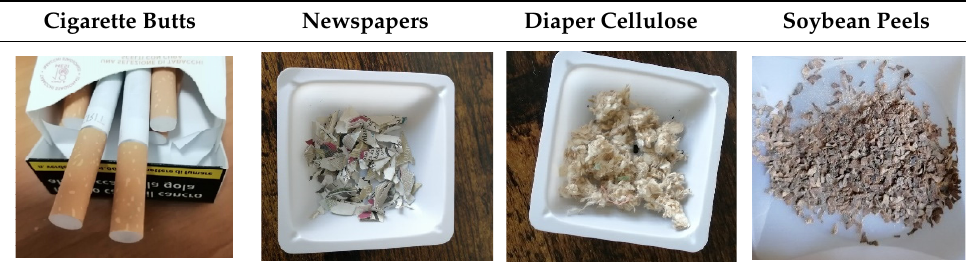
Figure 1. FTIR-ATR of the cellulose acetate (orange line) and cigare tt e bu tt s (blue line). Figure 2. Comparison of FTIR-ATR spectra between the commercial microcrystalline cellulose (blue line) with diaper cellulose (red line) and newspaper cellulose (green line).